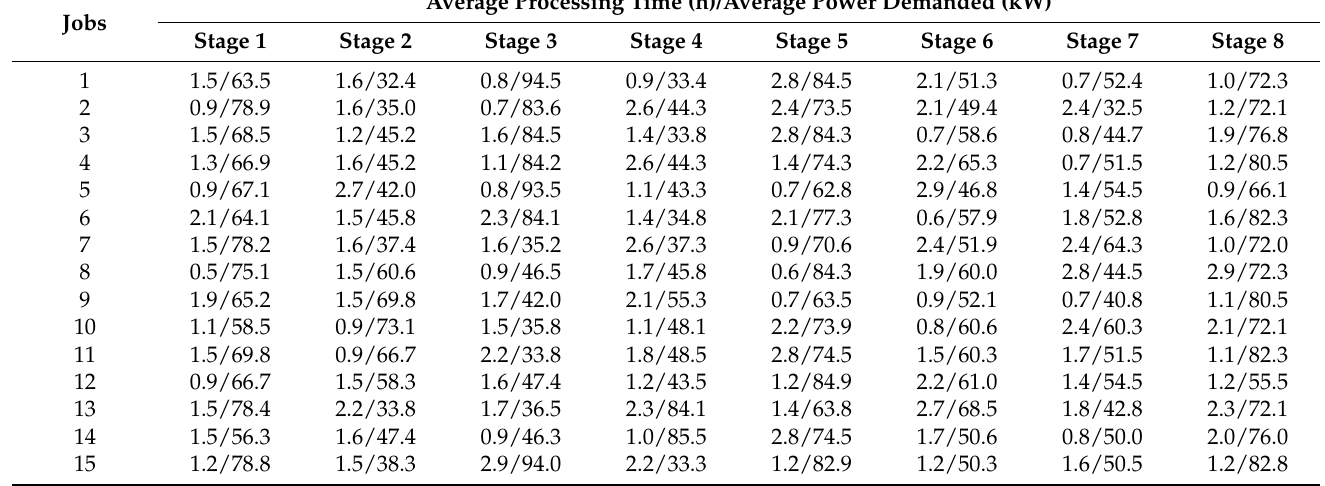
Table 2. Average processing time and power demand of each job.